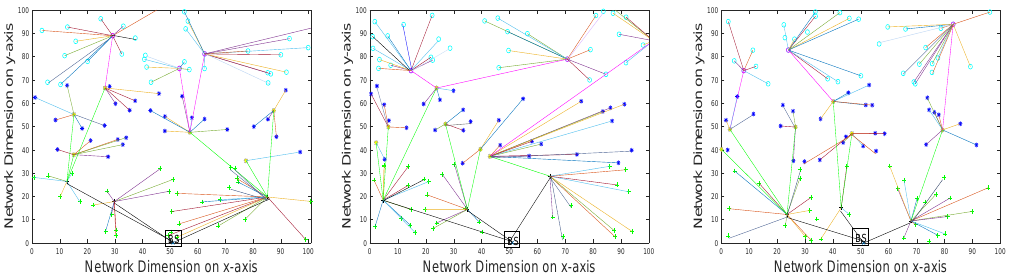
Figure 3. Iterative clustering topology in the case of the SDN-based Application-aware Centralized adaptive Iterative Flow Reconfiguring (SACFIR) routing